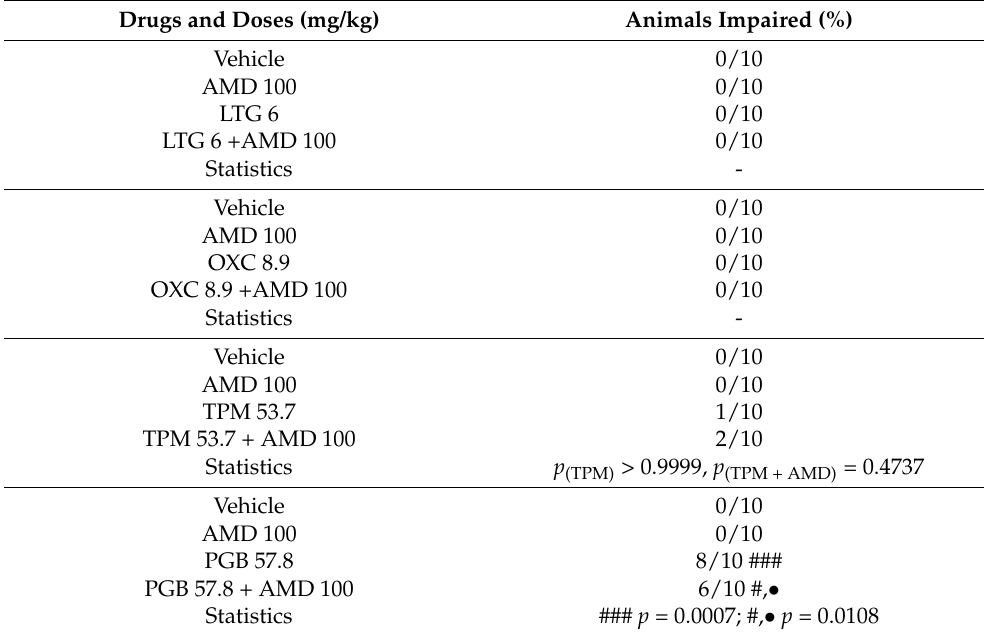
Table 1. Effects of acute amiodarone, antiepileptic drugs, and their combinations on motor perfor- mance in